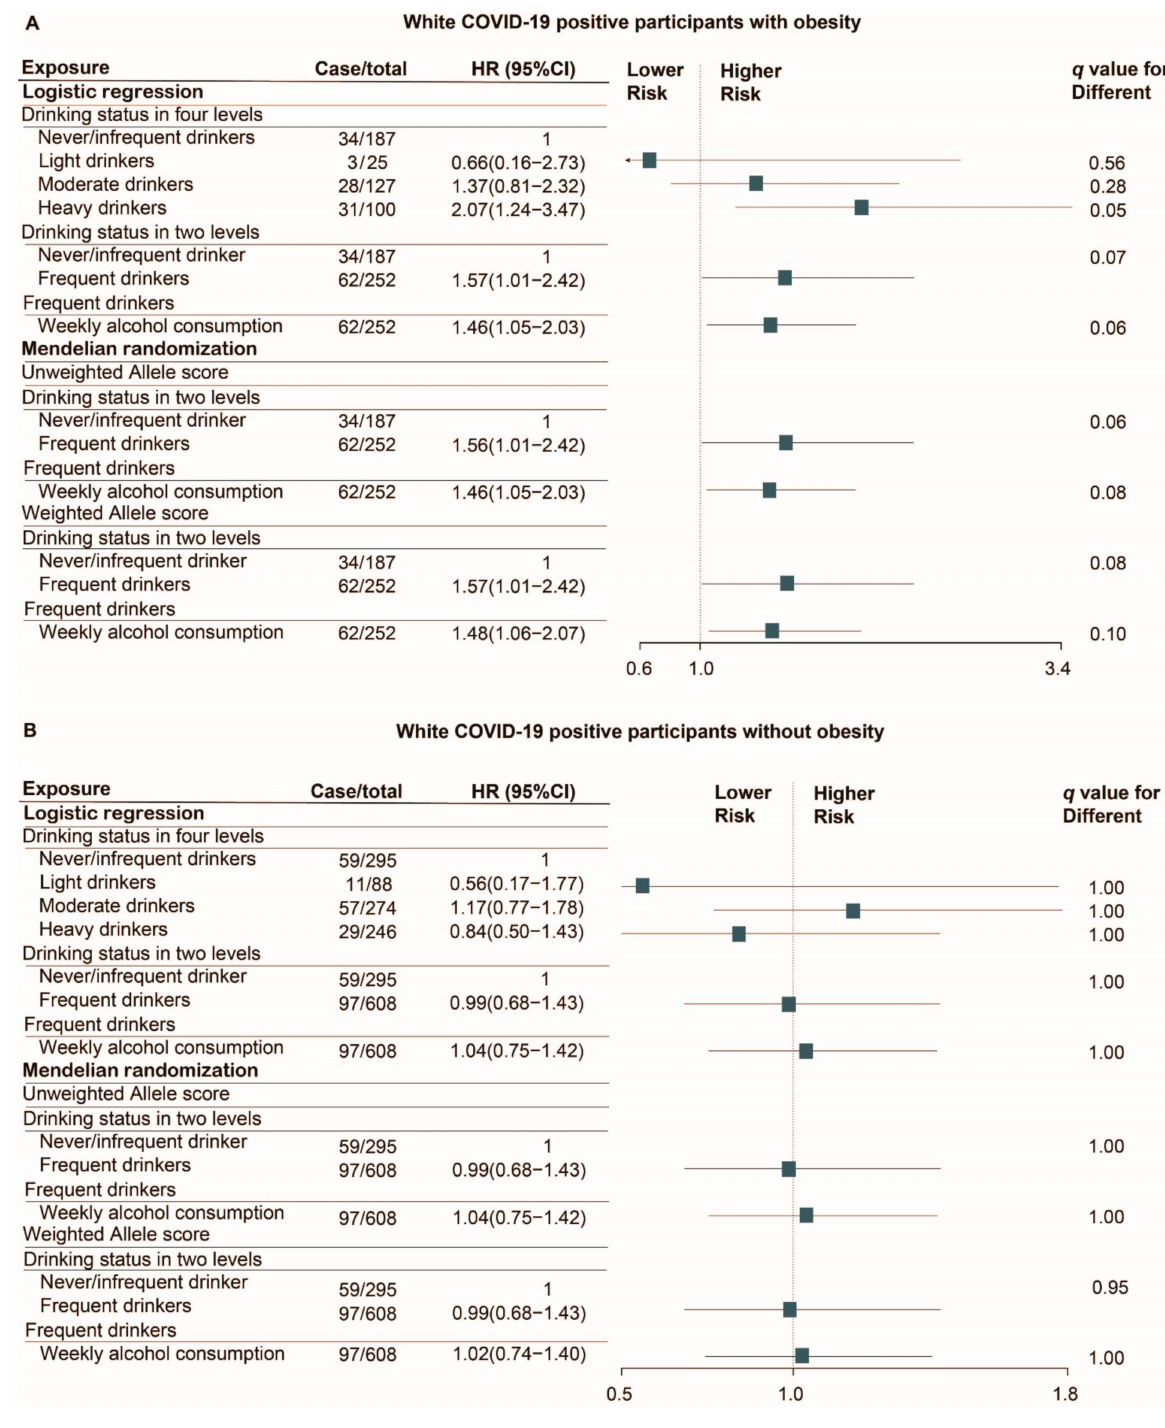
Figure 2. Cox regression and Mendelian randomization analyses of the association of alcohol consumption with the risk of death in white COVID-19 positive patients with ( A ) and without obesity ( B ). Analyses were performed in PSM cohort (Number of cases was counted from the cohort before PSM). Matching factors for PSM including age, sex, BMI categories, current smoking status, alcohol related diseases, asthma, emphysema, COPD, bronchitis/bronchiectasis, esophagitis, gastritis/duodenitis, peptic ulcer, GERD, hypertensive, chronic ischemic heart disease, heart failure, diabetes, dementia, renal failure, liver cirrhosis and/or liver failure, tumor, and AIDS. q-value was calculated by false discovery rate (FDR) method. Abbreviation: OR, odds ratio; HR, hazard ratio; CI, confidence interval; PSM, propensity score matching; BMI, body mass index; GERD, gastroesophageal reflux disease; COPD, chronic obstructive pulmonary disease; AIDS, acquired immunodeficiency